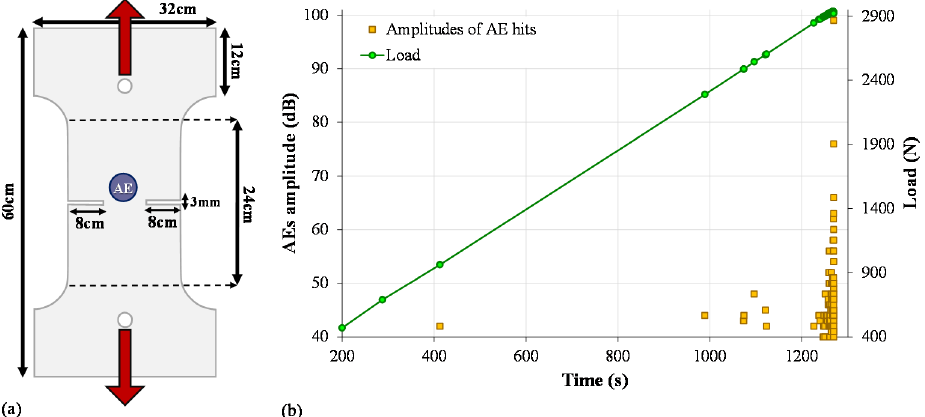
Figure 2. ( a ) Geometrical characteristics of the DENT specimen. The red arrows indicate the direction of the imposed tensile force. ( b ) The temporal evolution of the amplitudes of the acoustic hits in juxtaposition to that of the tensile force.